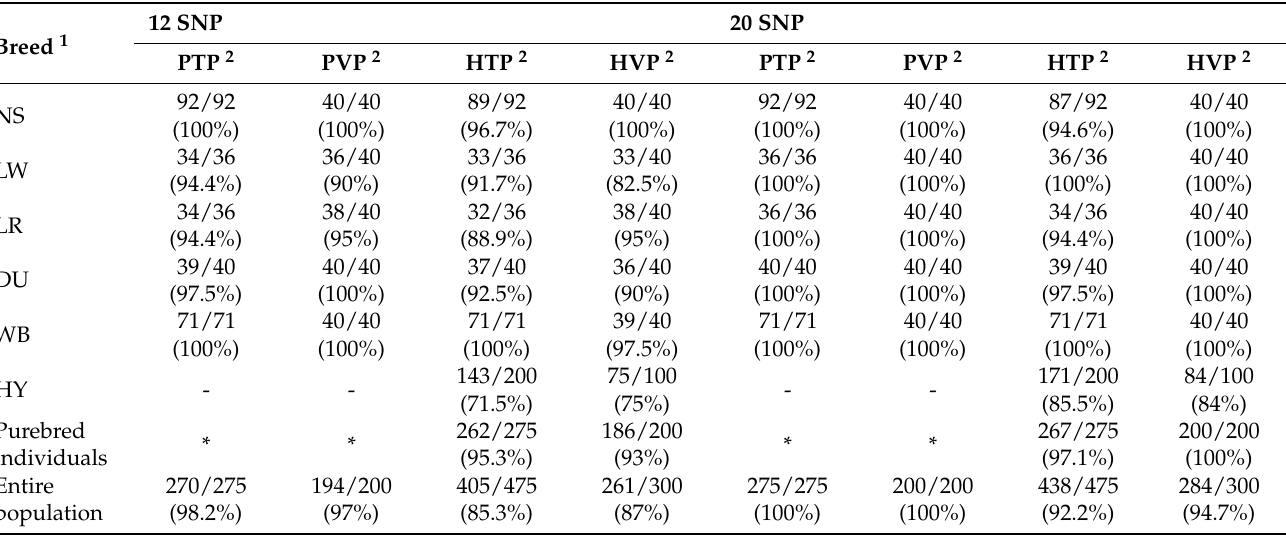
Table 2. Total assignation rate of individuals for 12-SNP and 20-SNP